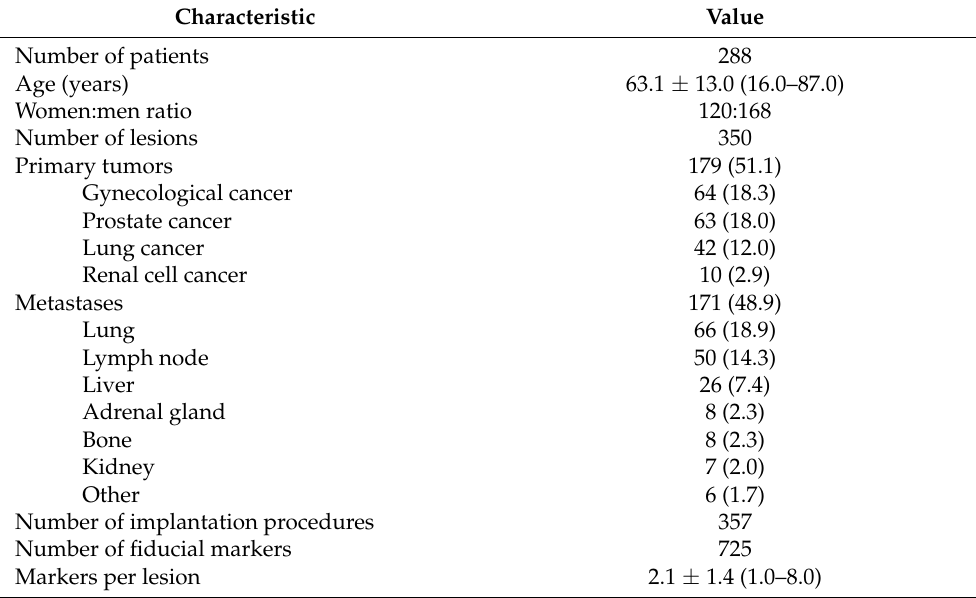
Table 1. Patient and lesion